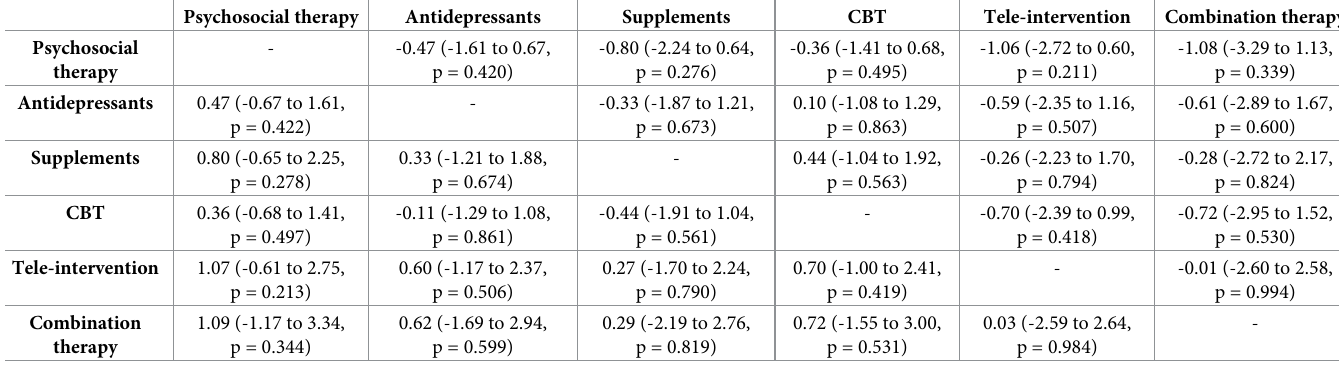
Table 2. Summary of network analysis for depression